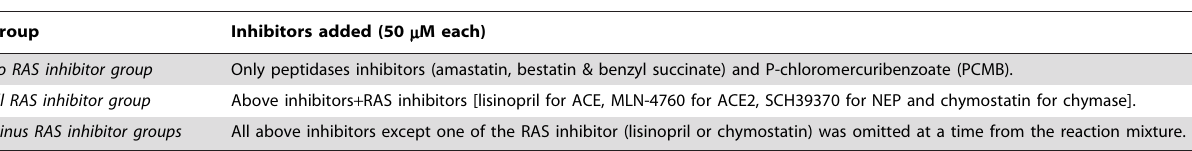
Table 3. Outline of enzyme inhibitors employed in the experiments.